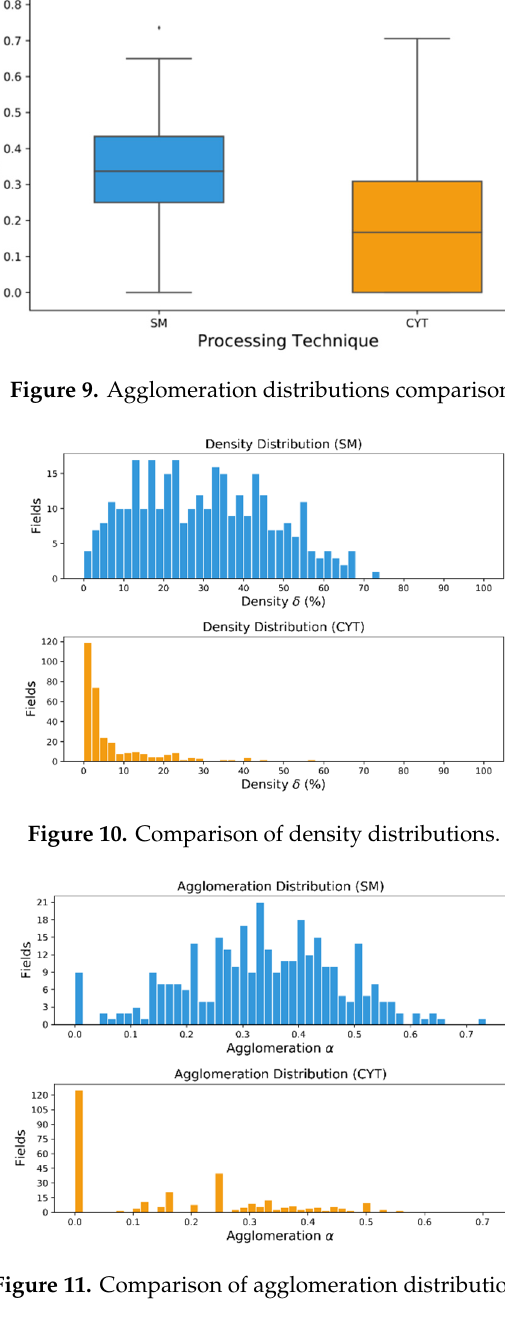
Figure 9. Agglomeration distributions comparison.